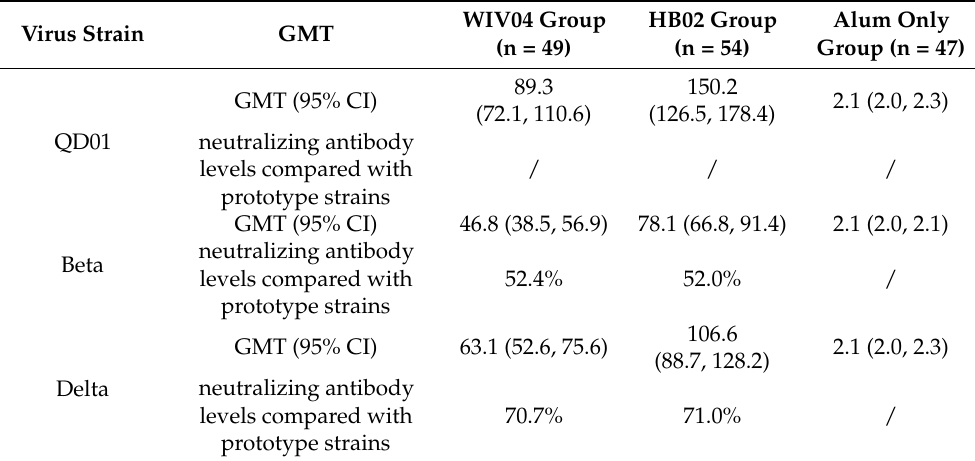
Table 3. Neutralizing antibody to various strains of